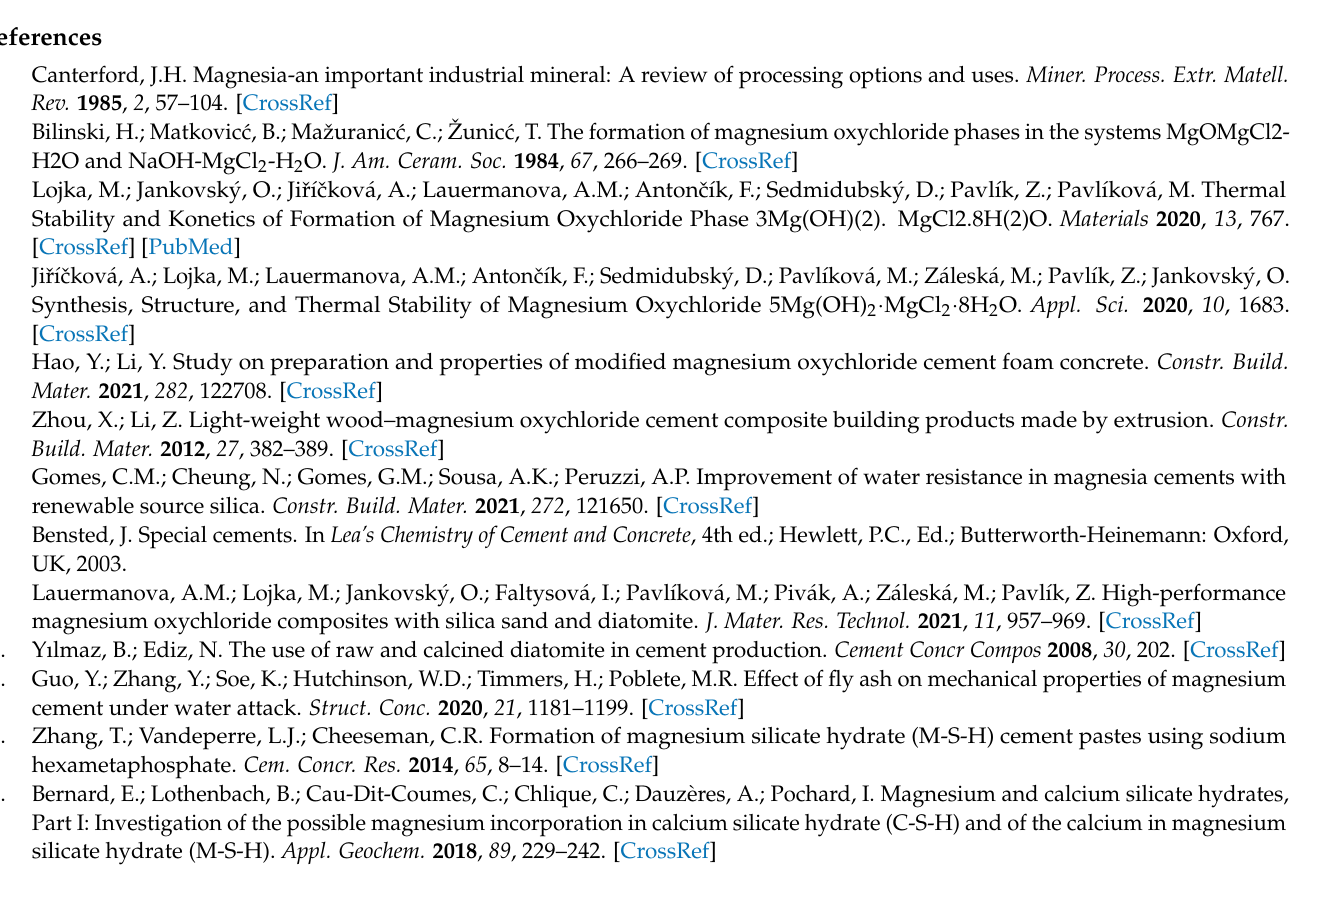
Figure S2: The micrographs of the diatomite powder obtained from SEM, Figure S3: Arrangement of samples and placing of sensor in Hot Disk measurement, Table S1: Assignments of the major absorption bands of MOC